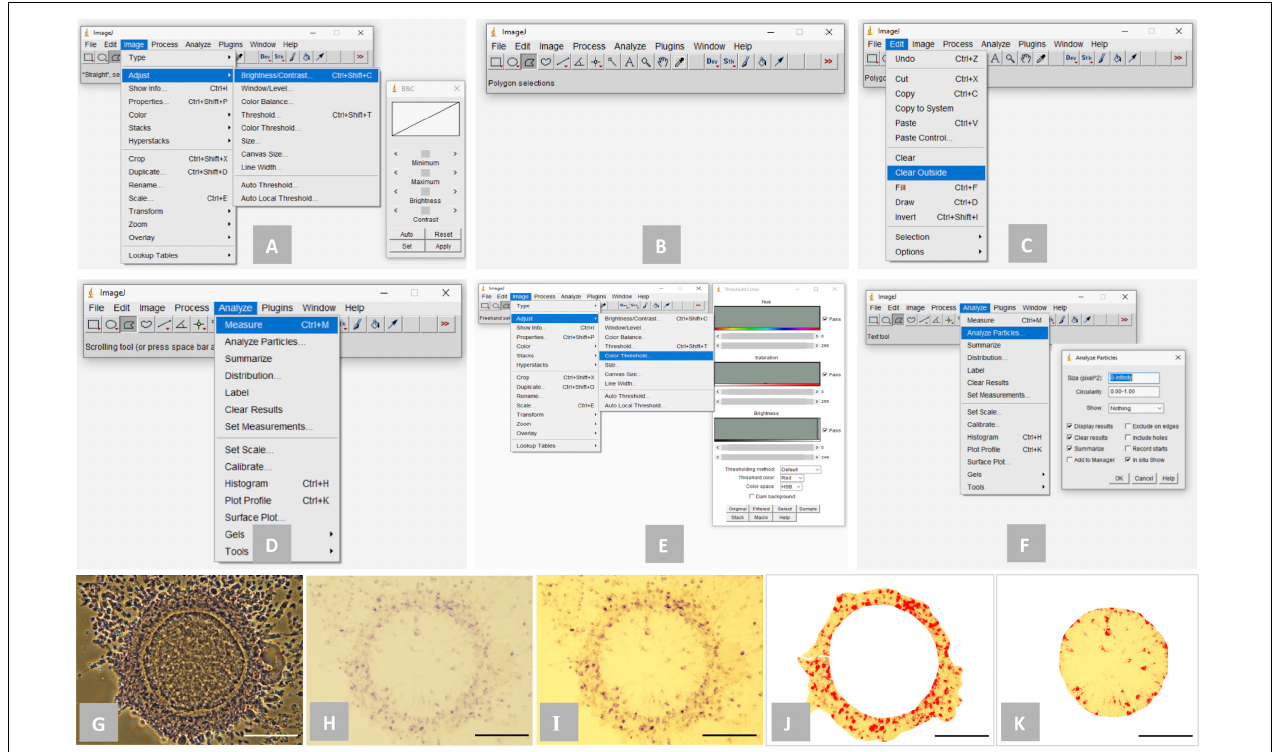
FIGURE 1 | Detection and quantification of the spots of formazan precipitates (dark purple/blue color) using ImageJ 1.52k software. (A) “Brightness/Contrast” tool for adjusting brightness and contrast of a bright-field image; (B) “Polygon selections” tool for selecting a specific zone; (C) : “Clear Outside” tool for clearing outside area beyond the selected zone; (D) “Measure” tool for determining the total area of a selected zone; (E) “Color Threshold” tool for highlighting the spots of formazan precipitates; (F) “Analyze Particles” tool for determining the total area of the highlighted spots of formazan precipitates; (G) phase-contrast image of a representative NBT-stained cumulus-oocyte complex (COC); (H) bright-field image of the COC; (I) bright-field image of the COC following the adjustment of brightness and contrast; (J) the zone of compact cumulus cell mass of the COC was selected and the spots of formazan precipitates were highlighted; (K) the zone of oocyte of the COC was selected and the spots of formazan precipitates were highlighted. Scale bar = 100 µ m.